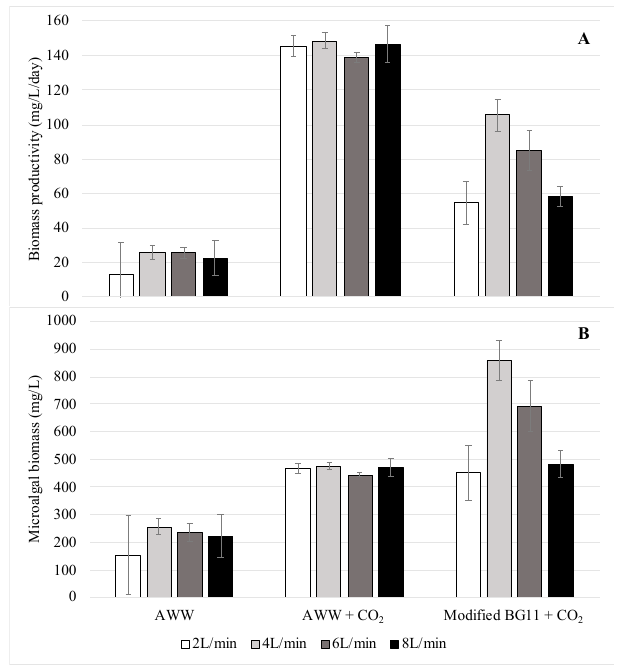
Figure 3. Average biomass productivity ( A ) and maximum microalgal biomass ( B ), with standard deviations, of C. sorokiniana cultured in three different groups: AWW = AWW air-lifted with pure air; AWW + CO 2 = AWW air-lifted with CO 2 -enriched air; BG11 + CO 2 = modified BG11 growth medium air-lifted with CO 2 -enriched air. Four different airflow rates were tested in each group (2, 4, 6, and 8 L/min). Number of samples per treatment = 3.